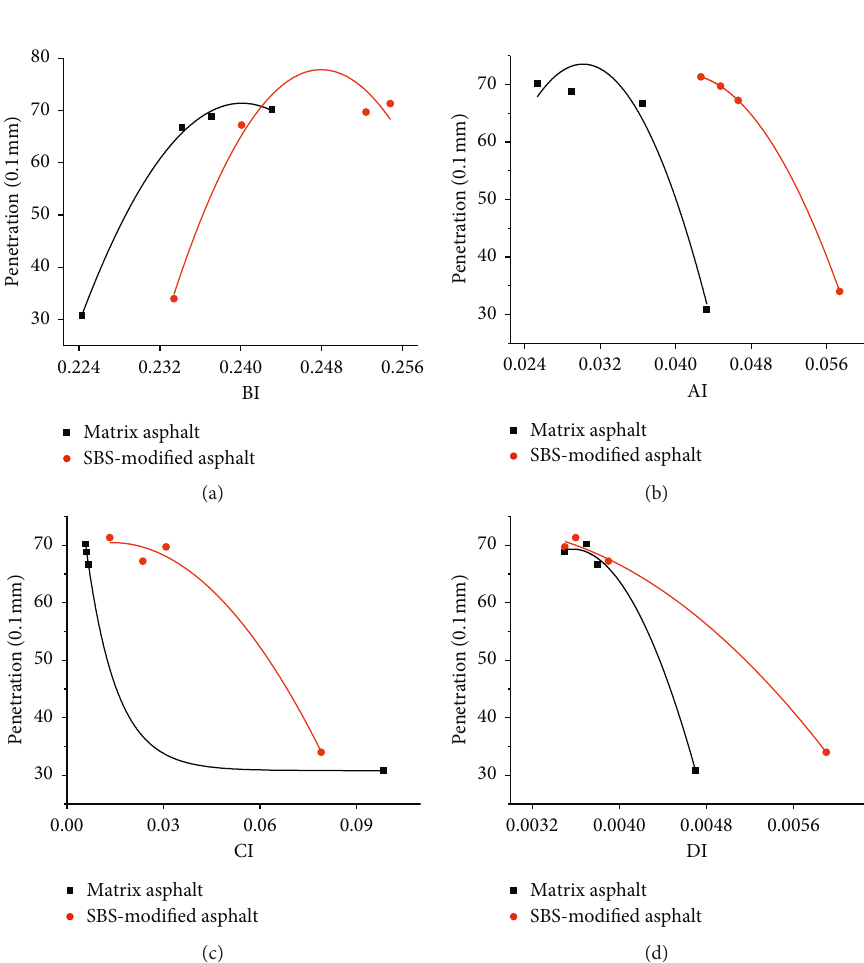
Figure 16: Relationships between the functional group indices and penetration.